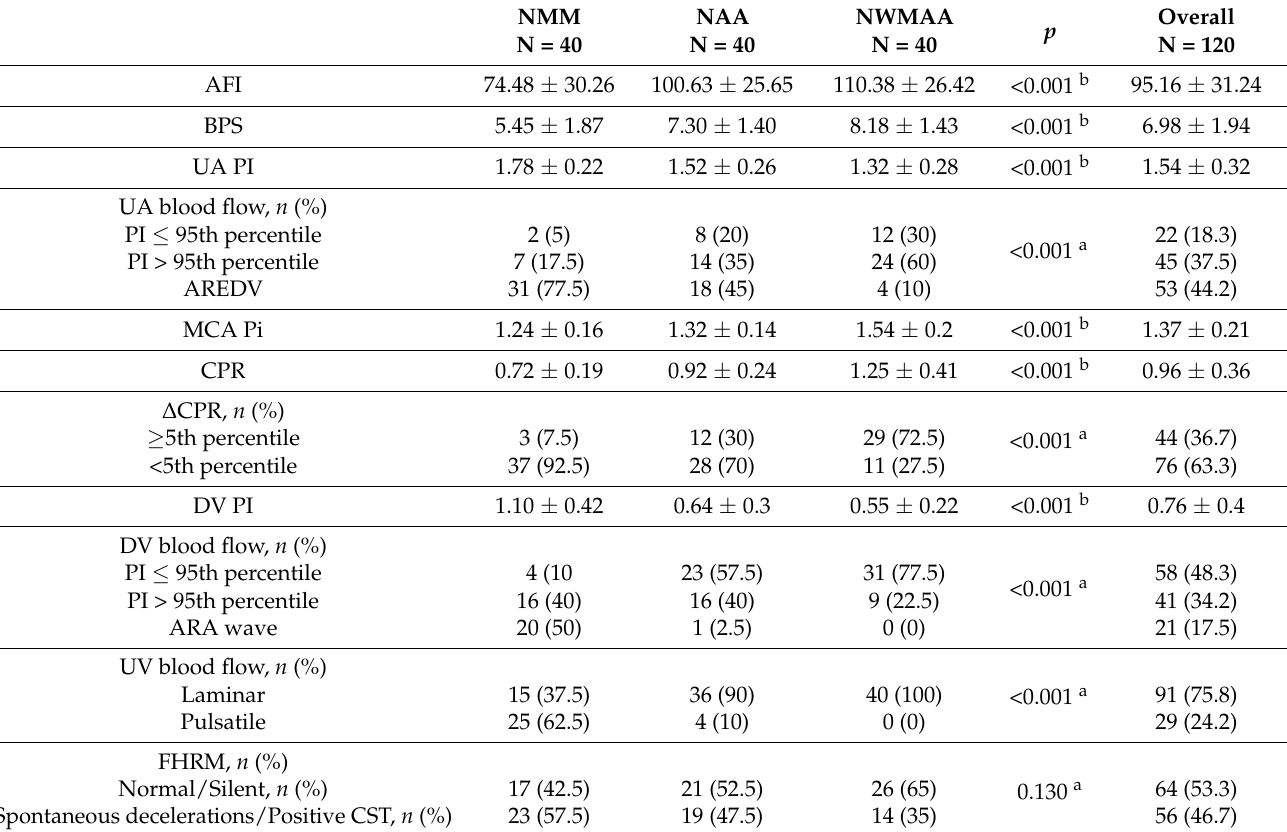
Table 3. Diagnostic parameters in early preterm growth-restricted neonates ( ≤ 32 wg).